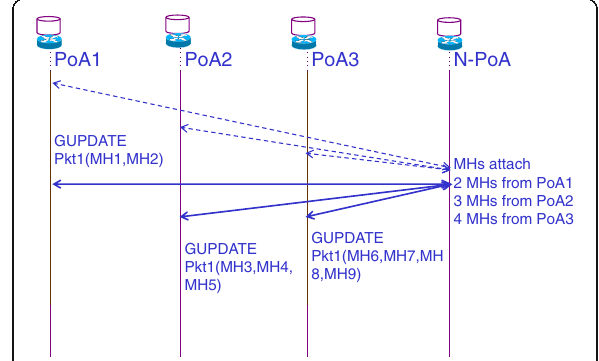
Fig. 10 Handover procedure of many MHs at the same time from different PoAs to the same new PoA using